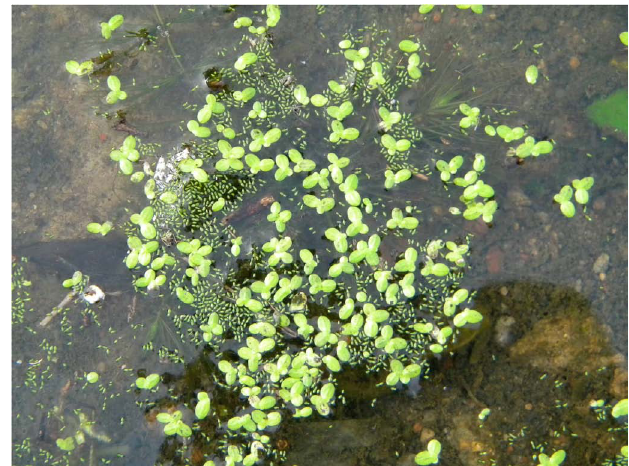
Figure 5. Aponogeton natans